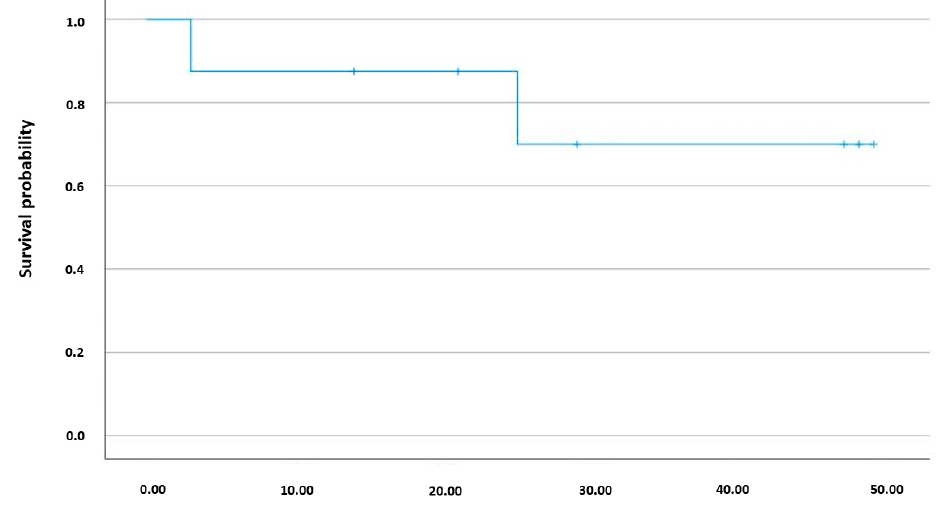
Figure 1. Kaplan–Meier survival plot: Kaplan–Meier analysis showing the survival rate among the 13 SS patients for a period of 48 months after hospital admission. 3.2. Urinary Cysteinyl Leukotrienes at Admission SS patients had significantly higher concentrations of u-CysLT at admission (1242 (599; 1583) pg/mg creatinine vs. 495 (373; 639) pg/mg creatinine, p < 0.010, SS vs. controls) (Figure 2 and Table 2).